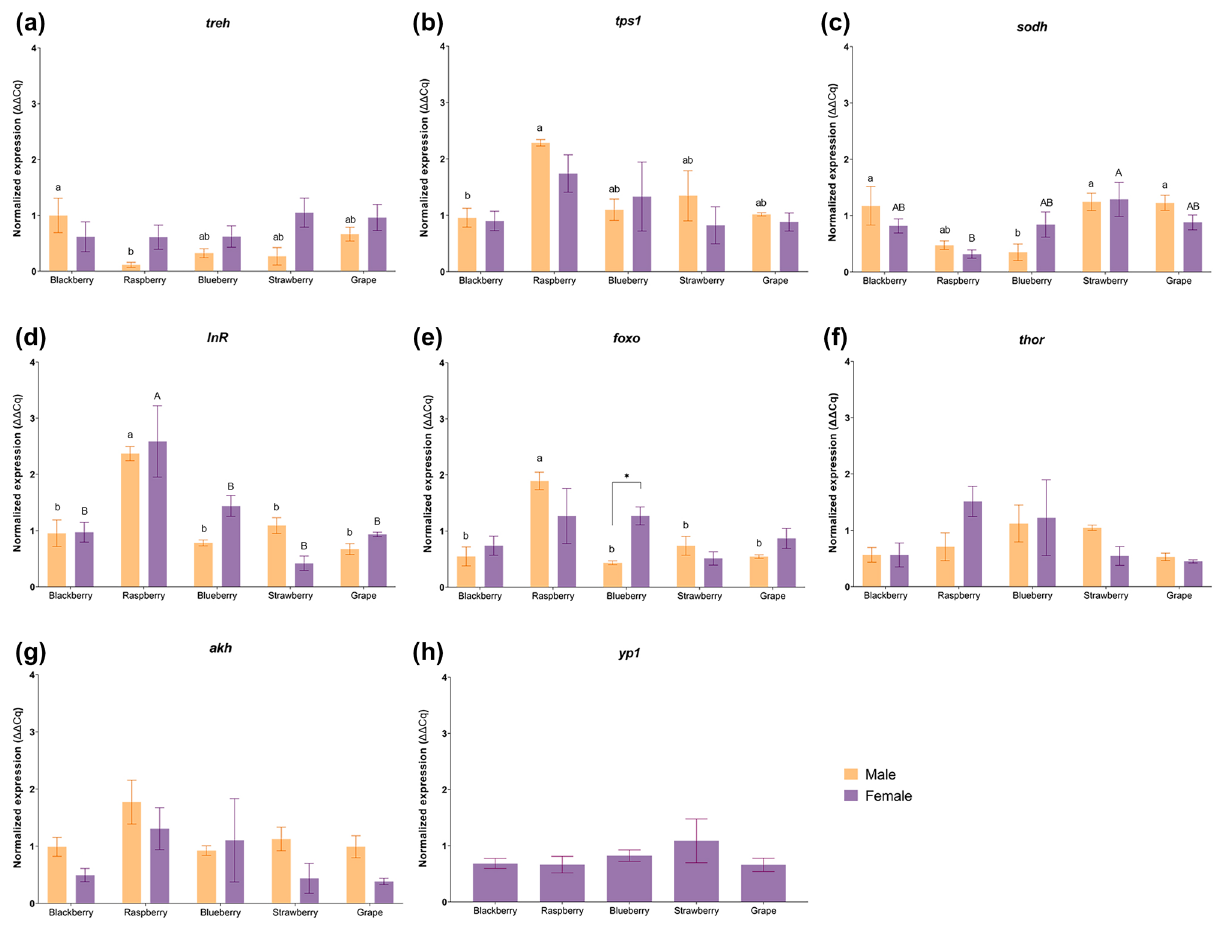
Figure 3. Expression of genes associated with metabolism pathways. ( a ) Trehalase ( treh ); ( b ) Trehalose-6- phosphate synthase 1 ( tps1 ); ( c ) Sorbitol dehydrogenase ( sodh ); ( d ) Insulin receptor ( InR ); ( e ) Forkhead box O ( foxo ); ( f ) thor ; ( g ) Adipokinetic hormone ( akh ); ( h ) Yolk protein ( yp1 ). Different lowercase letters represent statistically significant differences (p < 0.05) between males, different uppercase letters represent statistically significant differences (p < 0.05) between females, and * represent statistically significant differences (p < 0.05) between males and females fed on a specific fruit medium. No lowercase or uppercase letter means there was no significant difference among treatments within males or females,